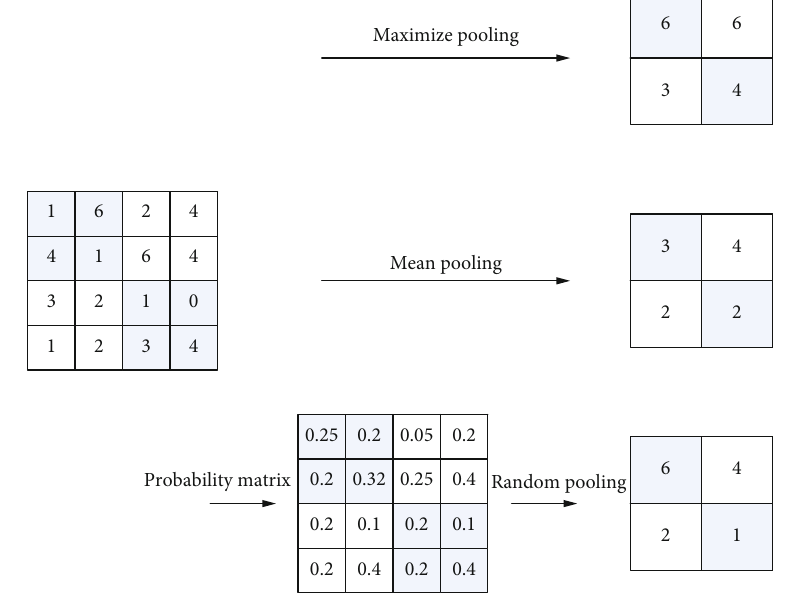
Figure 5: Common pooling methods.